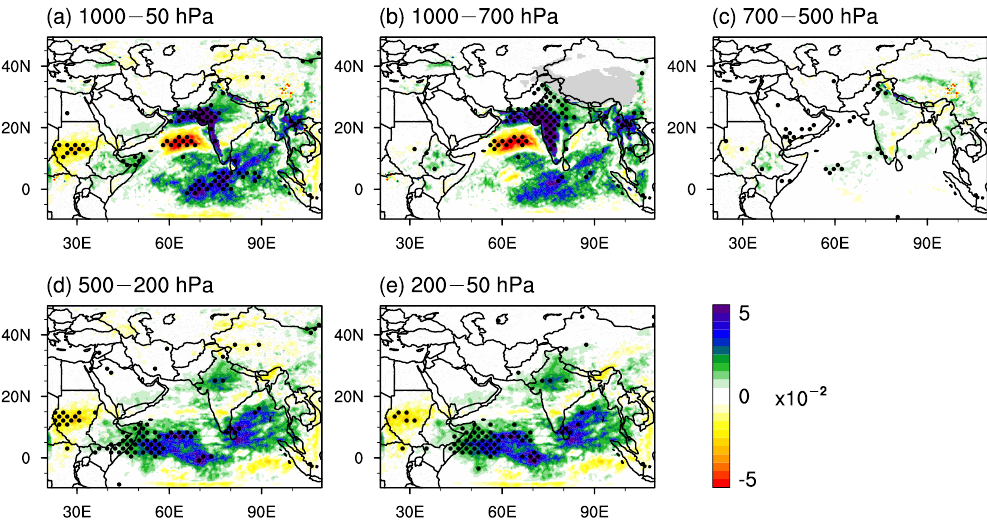
Figure 12. Spatial patterns of the ensemble means of cloud fraction responses (ALLF minus NDST; scale factor: 10 − 2 ) for JJA 2008 between various atmospheric layers. The dots indicate where cloud fraction responses have a 95% confidence level based on a one-sided Student’s t test.